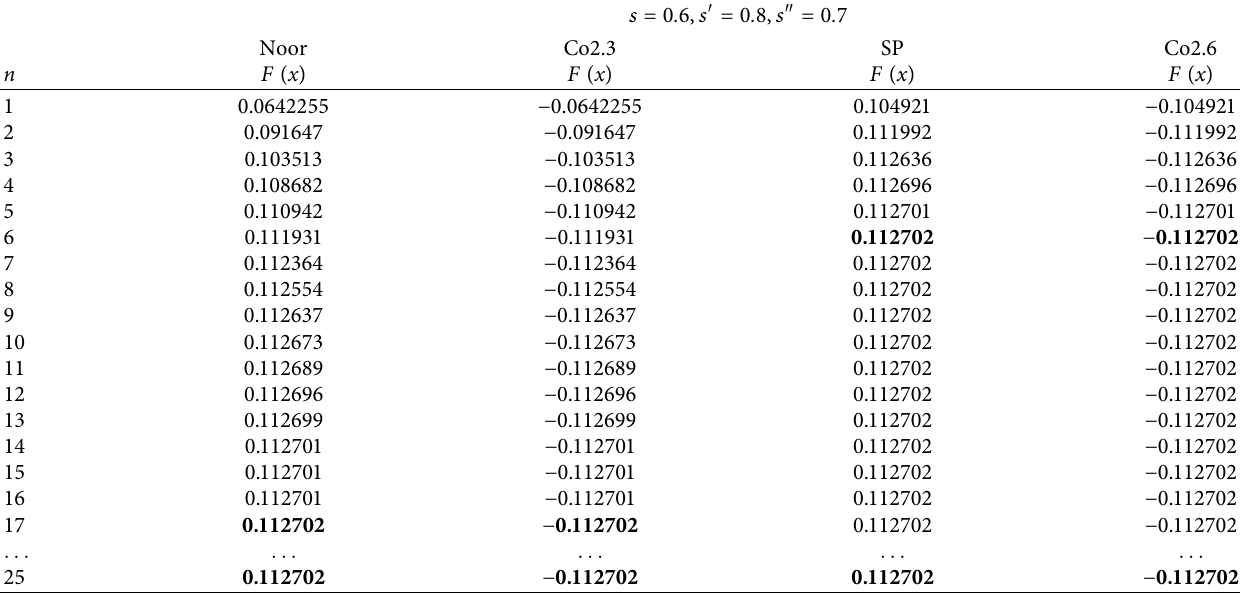
Table 2: Iterations of quadratic function s � 0 . 6 ,s ′ � 0 . 8 ,s ″ � 0 . 7.